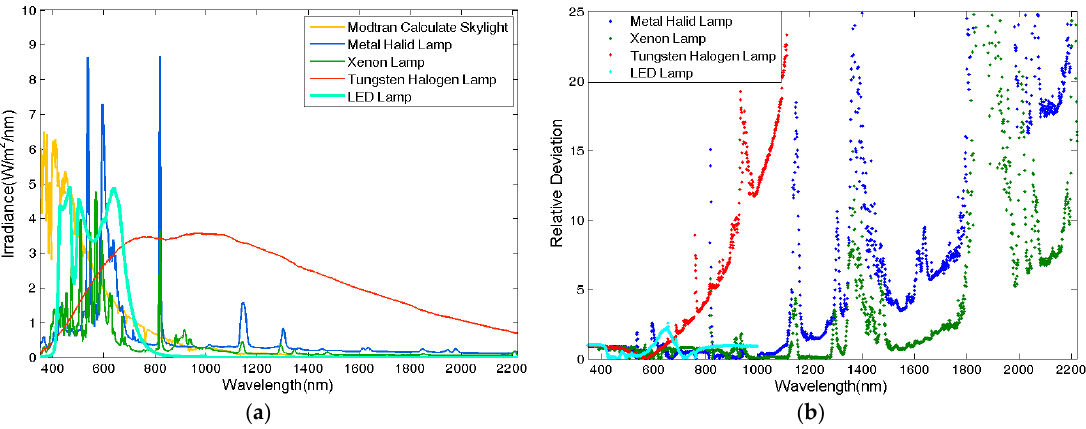
Figure 3. The radiances of different lamps compared with skylight radiance. ( a ) The spectra of lamps and ( b ) the relative deviations of lamps.